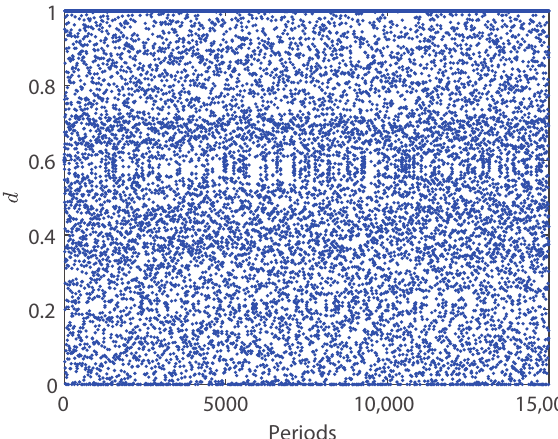
Figure 12. Evolution of the duty